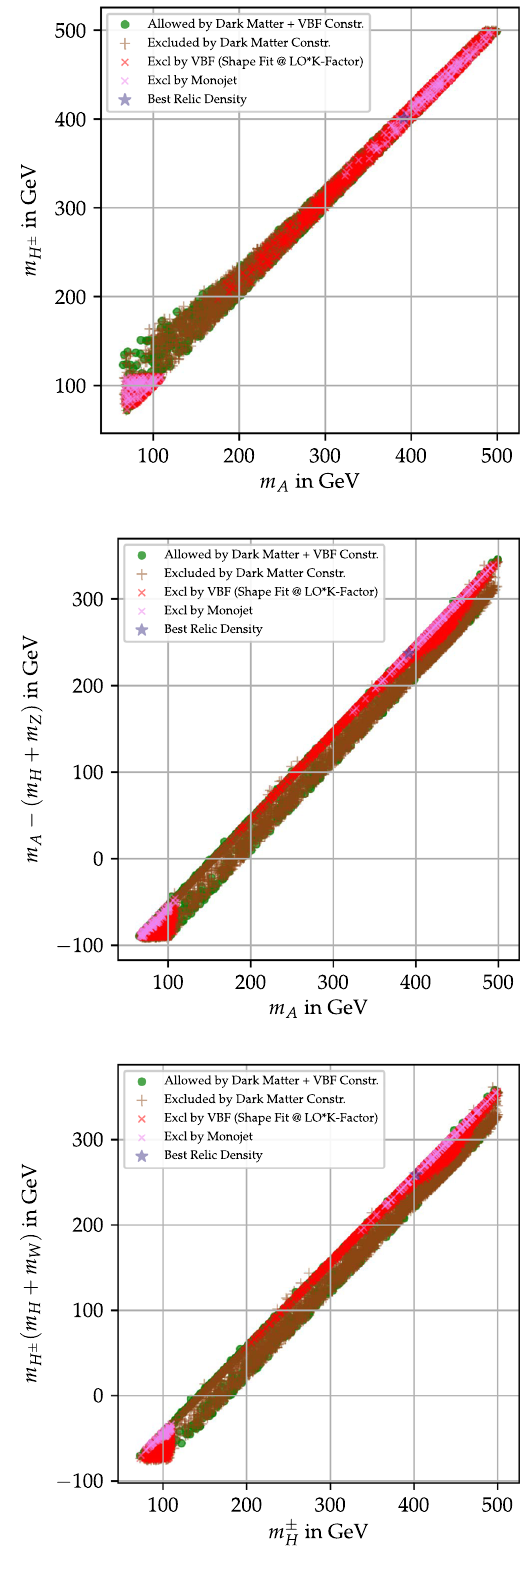
Fig. 5 Allowed combinations of the scalar masses m H ± , m A and m H which are relevant for collider analysis of the channels pp → H A and pp → H ±